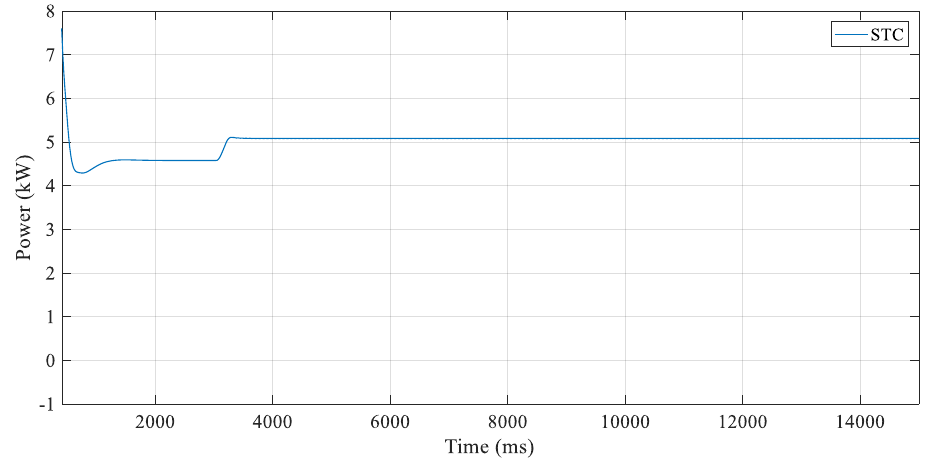
Figure 17. Power of the grid under normal condition.